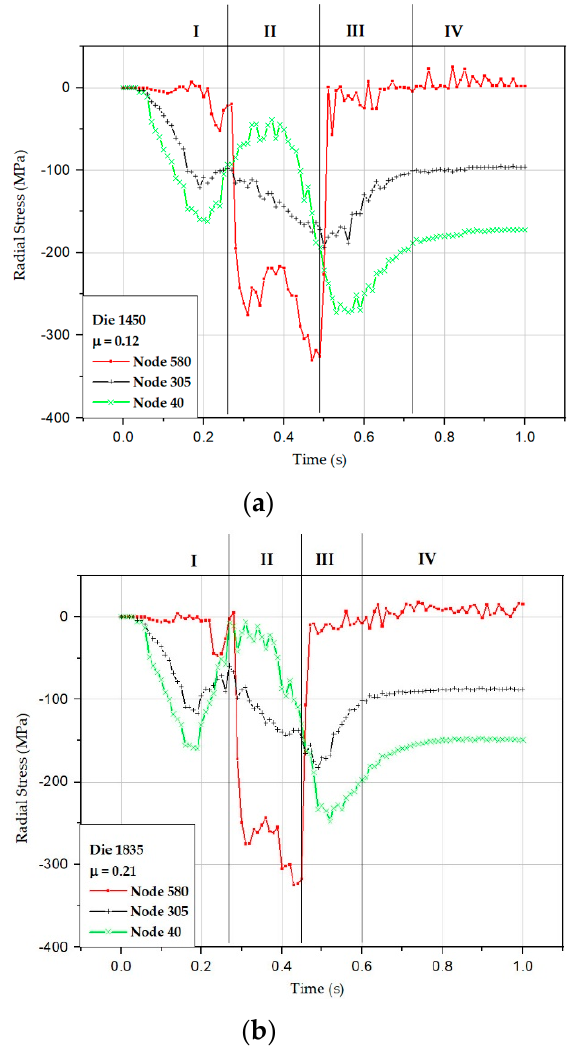
Figure 6. Radial stress as a function of time for the three nodes 580, 305, and 40. The calculations are carried out for the dies 1450 ( a ) and 1835 ( b ).